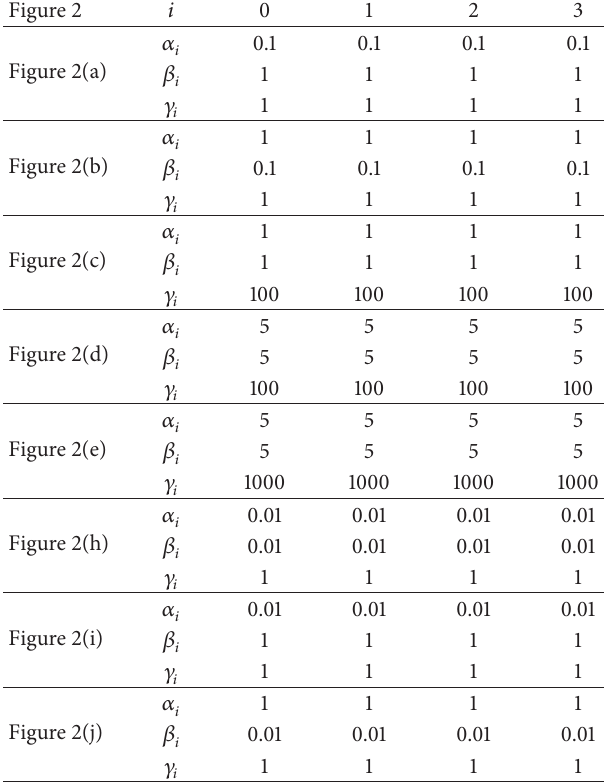
Table 2: Shape parameters value for Figure